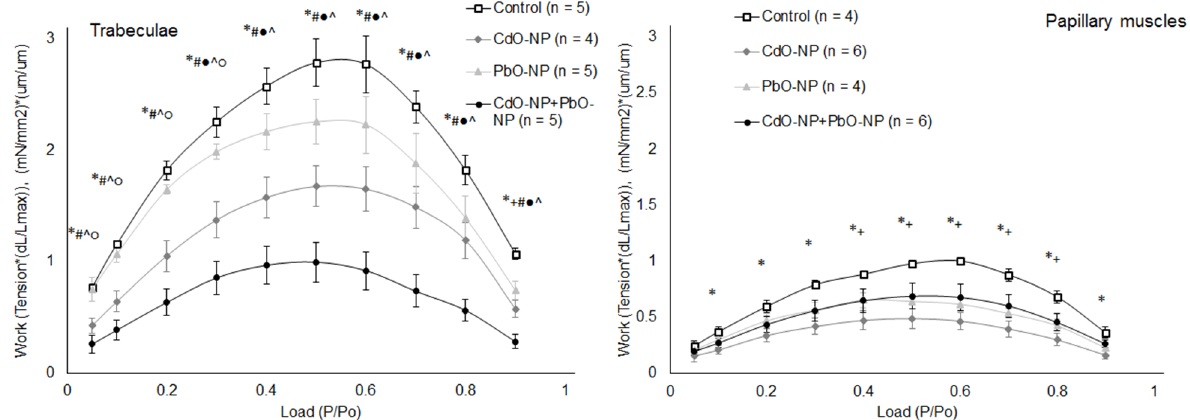
Figure 8. The work–afterload relationships of isolated right ventricular trabeculae (left panel) and papillary muscles (right panel) in the control, PbO–NP, and CdO–NP groups. Data are shown as mean ± S.E. There are significant differences: *— CdO–NP vs. Control, +—PbO–NP vs. Control, #—CdO–NP + PbO–NP vs. Control, ● —CdO–NP + PbO–NP vs. CdO–NP,